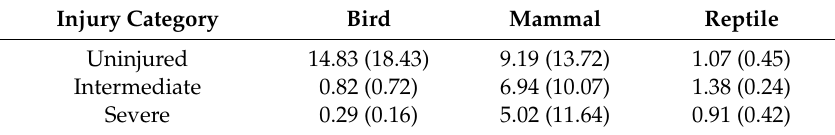
Table 8. Mean mass ± standard deviation (kg) of all three taxa of native by-catch (bird, mammal and reptile) in each of the summarised injury categories (uninjured, intermediate and